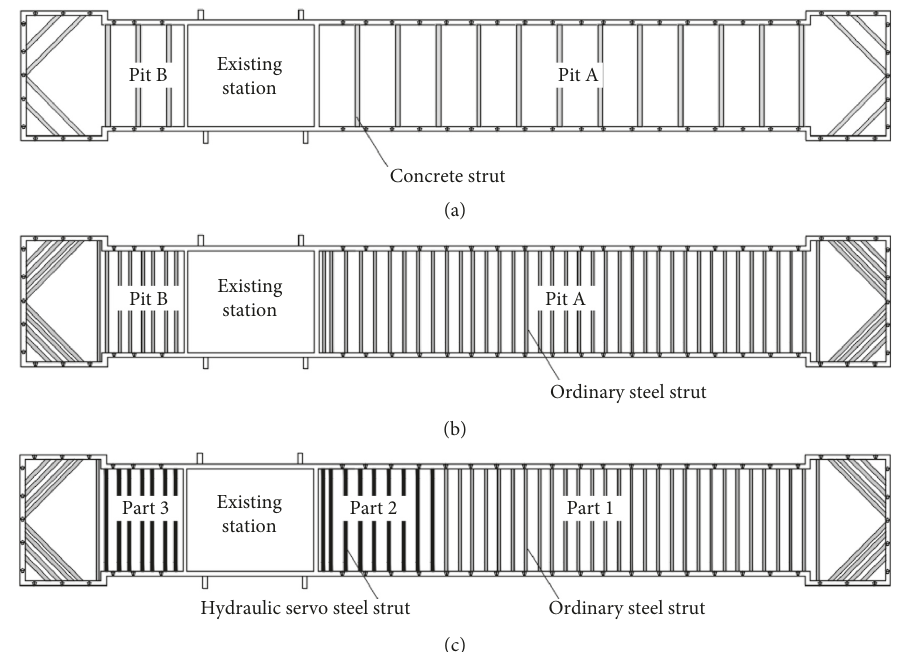
Figure 3: Plan view of the foundation pit: (a) layout of 1 st and 5 th struts; (b) layout of 2 nd strut; (c) layout of 3 rd , 4 th , 6 th , and 7 th struts. Unit: m